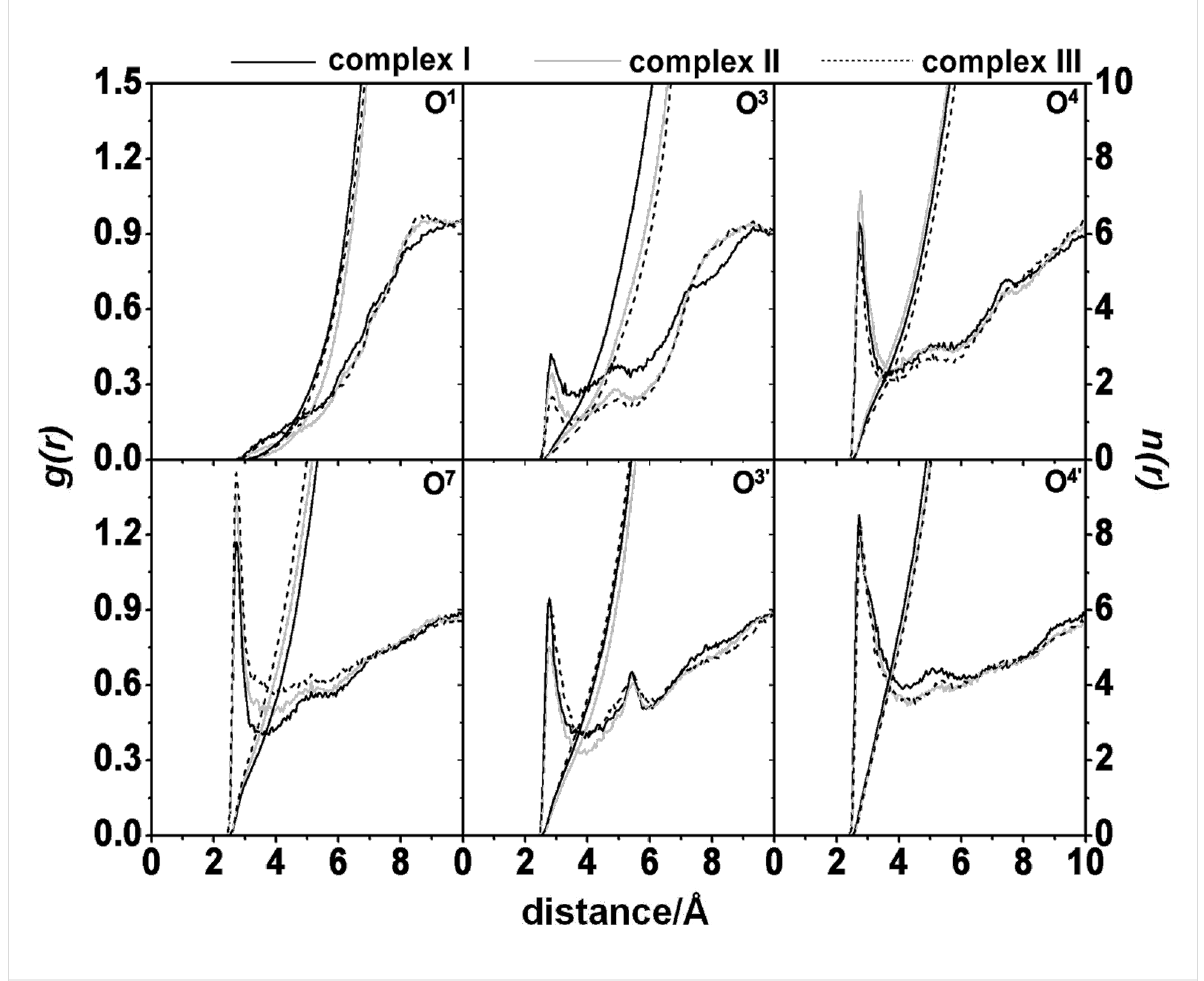
Figure 6: Radial distribution function (RDF) of oxygen atom of water molecules around the heteroatoms of fisetin in the complexation with β -CD for the three focused systems: complexes I (solid black line), II (solid grey line) and III (dashed line).